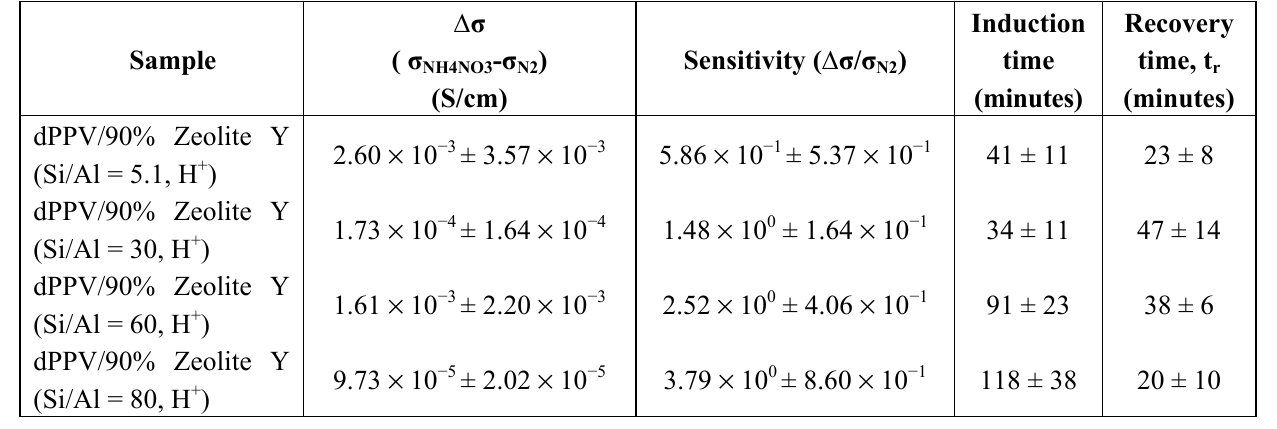
Table 2. The electrical conductivity sensitivity and the induction and recovery times